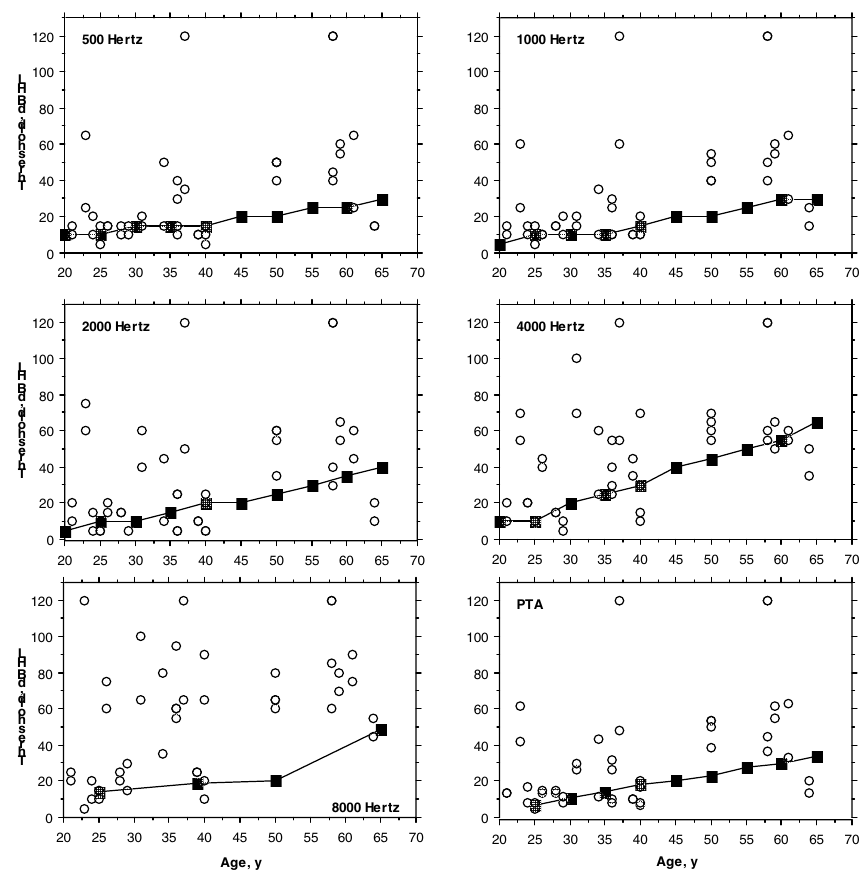
Figure 2 Comparison of thresholds for 20 Fabry hemizygotes, aged 25 years and older (circles), with 95 th percentile data (squares) from the International Organization for Standardization 1990 standards for 0.5, 1, 2, 4 frequencies and PTAs or, for 8 kHz, with the 90 th percentile. dB HL indicates decibel hearing